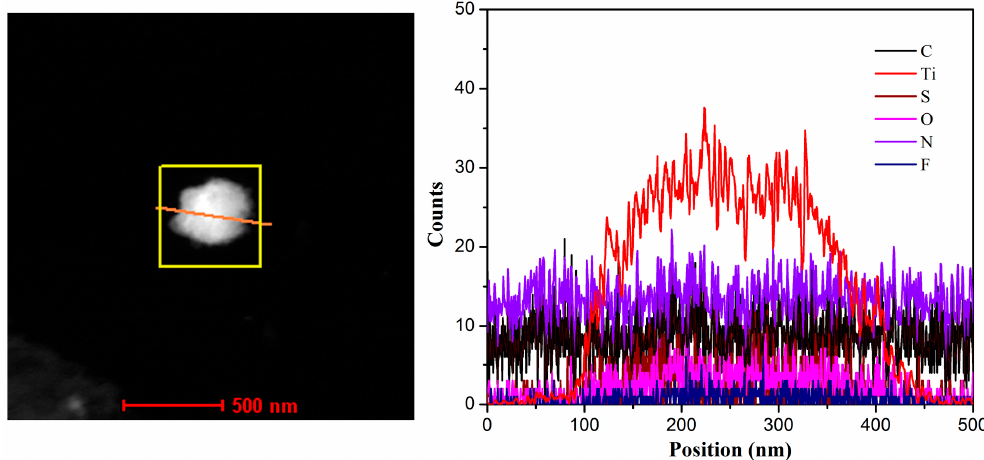
Figure 5. TEM image with elemental line scans of C/N/O/F/S/Ti in MXene-SO3H/RhB composite film.